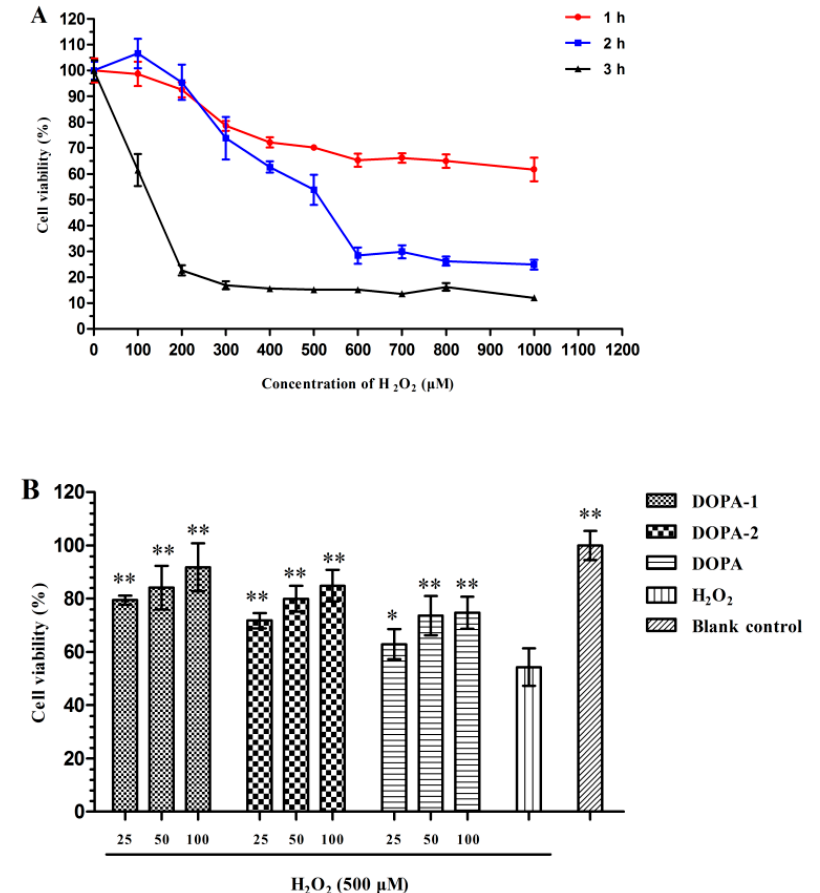
Figure 6. ( A ) Effects of H 2 O 2 on the RAW 264.7 cells viability with various concentration of H 2 O 2 for different times; ( B ) Effects of D. officinale polysaccharides on viability of H 2 O 2 -treated RAW 264.7 cells. Values were shown as means ± SD ( n = 5). * p < 0.05, ** p < 0.01 compared to the H 2 O 2 -treated group.